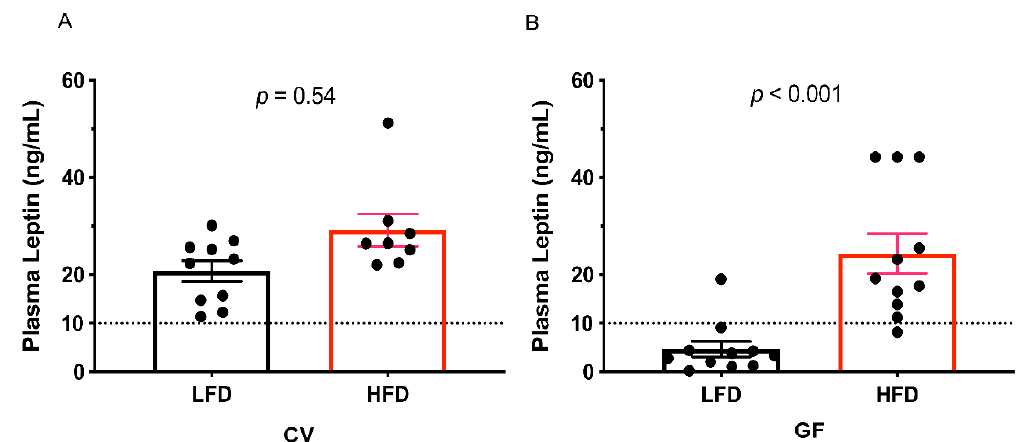
Figure 2. Both the IMB and the HFD increase plasma leptin concentrations in male SW mice. Quantification of plasma leptin concentrations in ( A ) CV ( n = 10) and ( B ) GF ( n = 11) mice on the LFD control or the HFD. The values for individual mice are shown as dots, the means as bars, and horizontal lines indicate the standard error of the mean ( ± SEM). The dotted horizontal lines indicate the cut-o ff for elevated concentrations ( ≥ 10 mg / dL), indicative of hyperleptinemia [28]. Abbreviations: low fat diet.